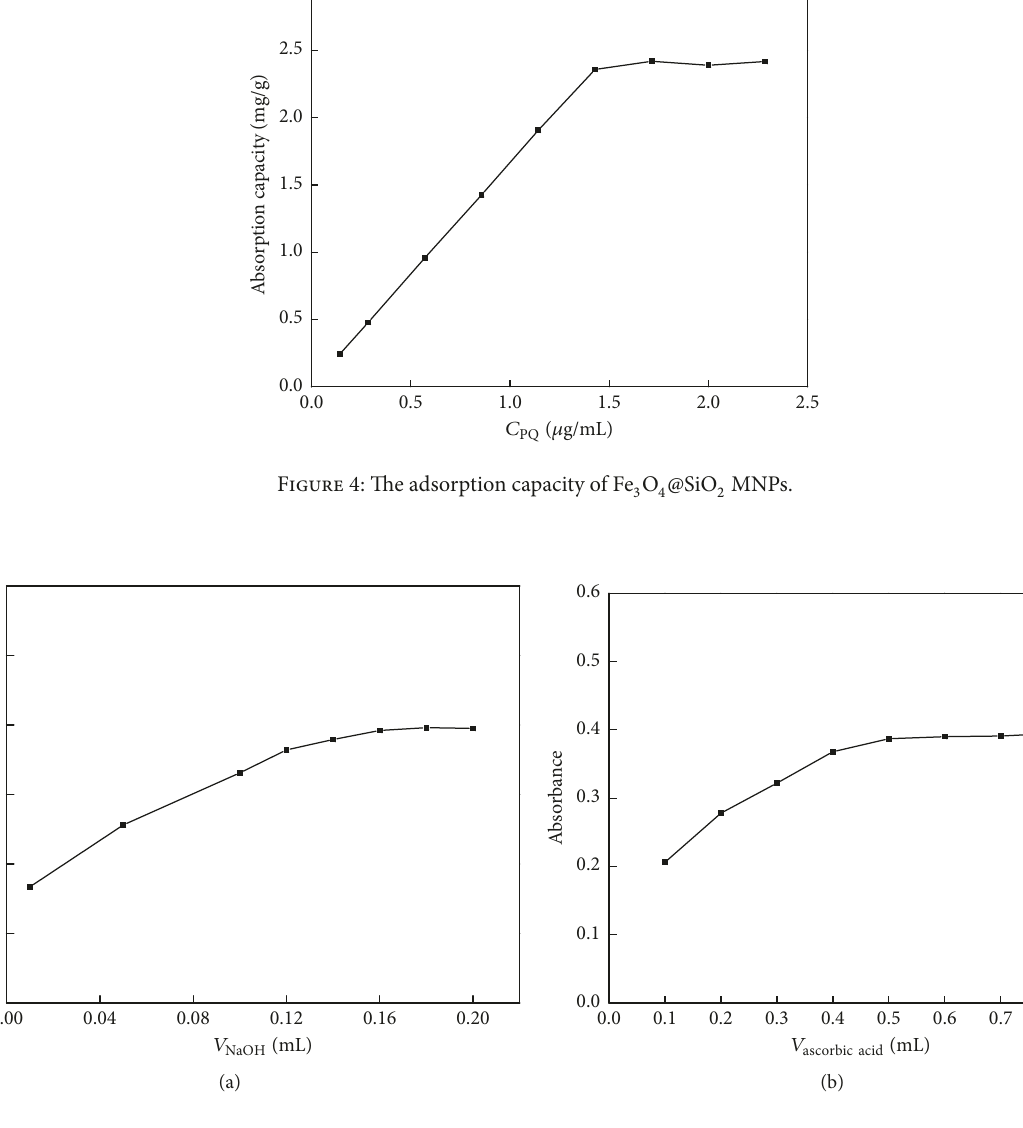
Figure 5: The volume effect of NaOH and ascorbic acid.